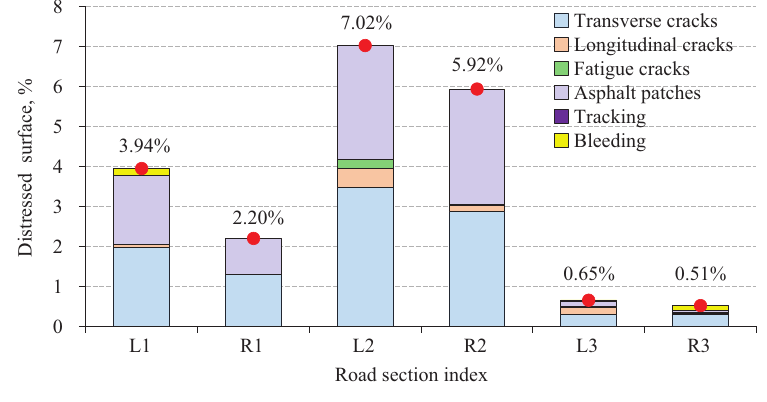
Figure 7. Pavement distress in